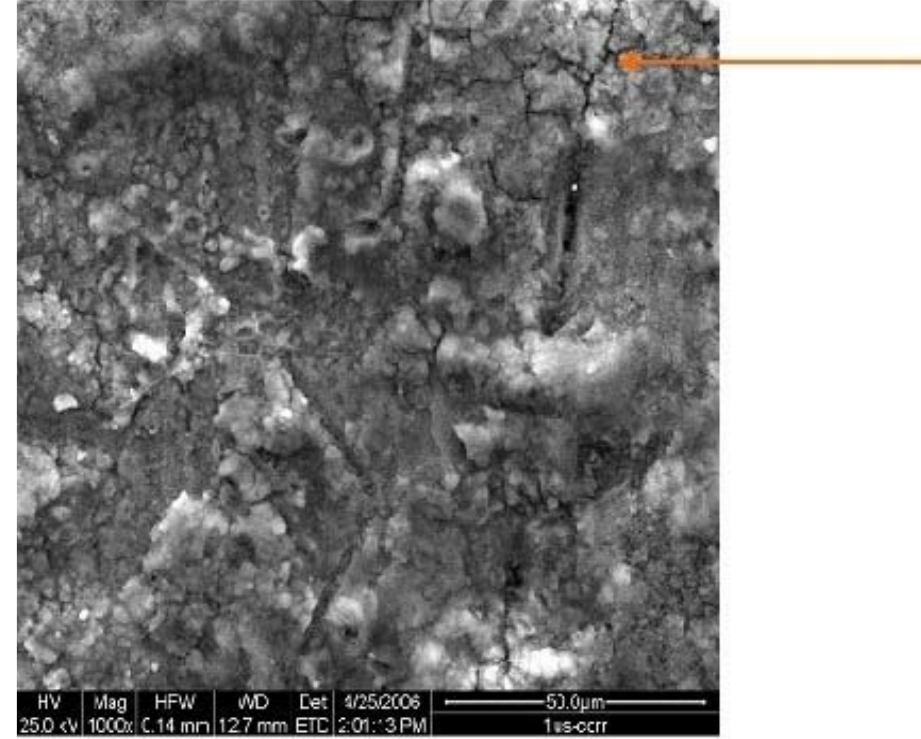
Figure 6. SEM of surface of 1us after polarization test in SBF.